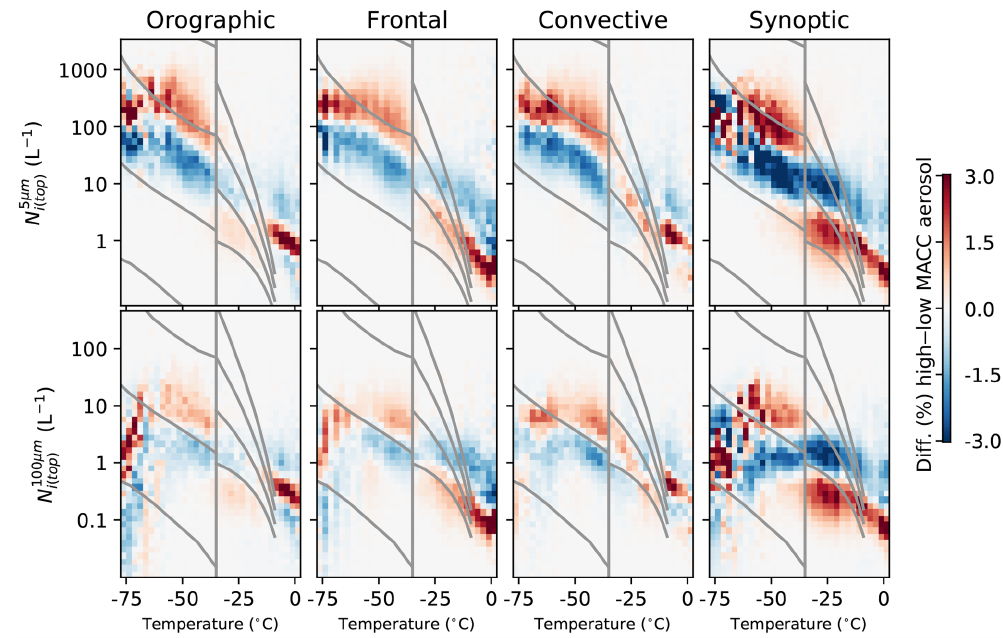
Figure 6. The difference in the conditional histograms between cases with high MACC total aerosol mass concentration ( > 6µgm − 3 ) and low total mass concentration ( < 6µgm − 3 ) for the four main regimes. The grid lines are the same as Fig. 2. The upper set of plots show the . The changes sum to zero vertically; red over blue indicates an increase in the N 5µm and the lower in N 100µm difference in N 5µm i ( top ) i ( top ) for a given temperature and